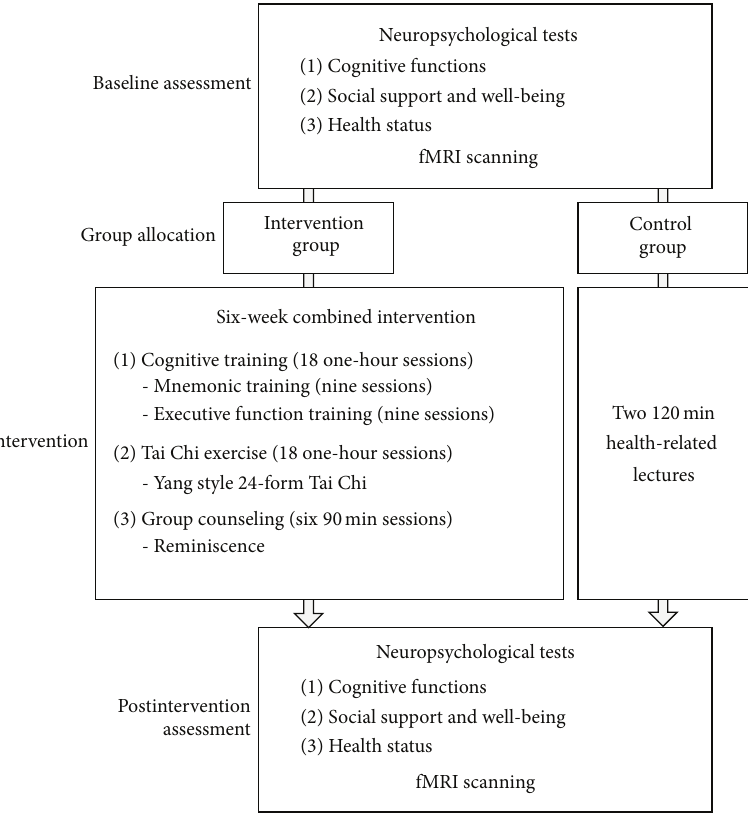
Figure 1: The procedure for this